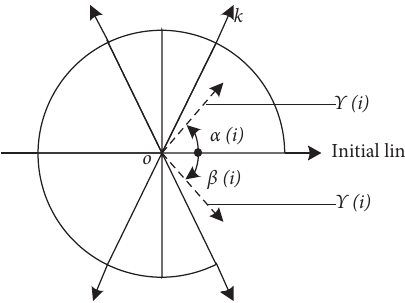
Figure 6: Schematic diagram of